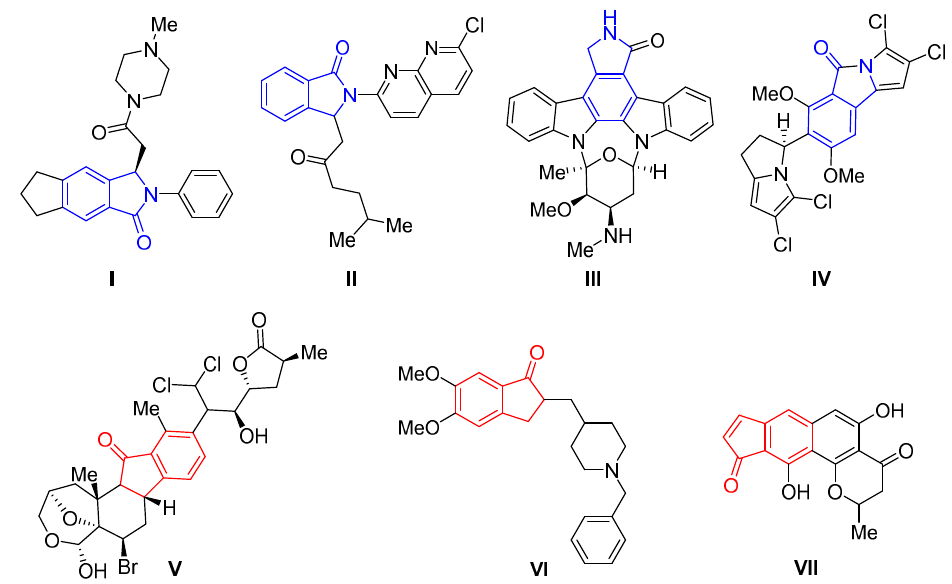
Figure 1. Biologically active isoindolinone and indanone